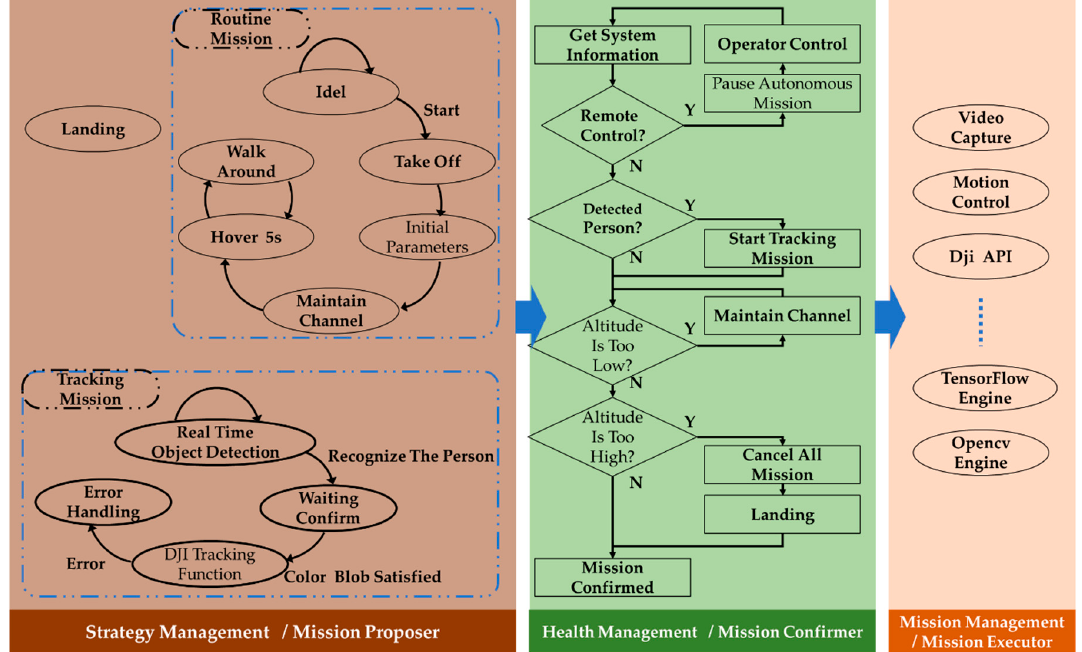
Figure 3. Software framework. In the program, the strategy management generates the missions and proposes one mission to be executed by the health management. The health management monitors the current system state and the security information, adjusts the mission if necessary and confirms it. The mission management would conduct the confirmed mission with the help of basic functions.